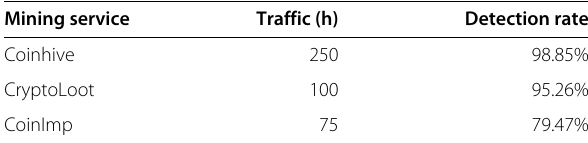
Table 3 Detection results for in-browser